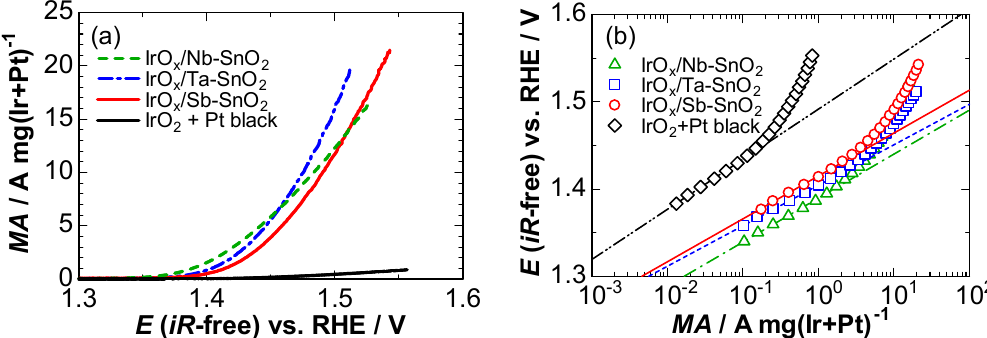
Figure 2. ( a ) iR -free anodic polarization curves for IrO x /M-SnO 2 and conventional (IrO 2 + Pt black) catalysts in air-saturated 0.1 M HClO 4 solution at 80 °C with a flow rate of 160 cm s −1 . The current is shown as the apparent mass activity ( MA ) based on the mass of Ir (or Ir + Pt for the conventional catalyst) loaded on the electrode substrate. ( b ) Tafel plots for iR -free anodic polarization curves shown in ( a ). The values of Tafel slopes for IrO x /Nb-SnO 2 , IrO x /Ta-SnO 2 , IrO x /Sb-SnO 2 , and conventional catalysts at E < 1.43 V were 51, 46, 52, and 63 mV, respectively. Data for IrO x /Nb-SnO 2 and IrO x /Ta-SnO 2 are taken from [32]; a small error in the iR subtraction has been corrected.